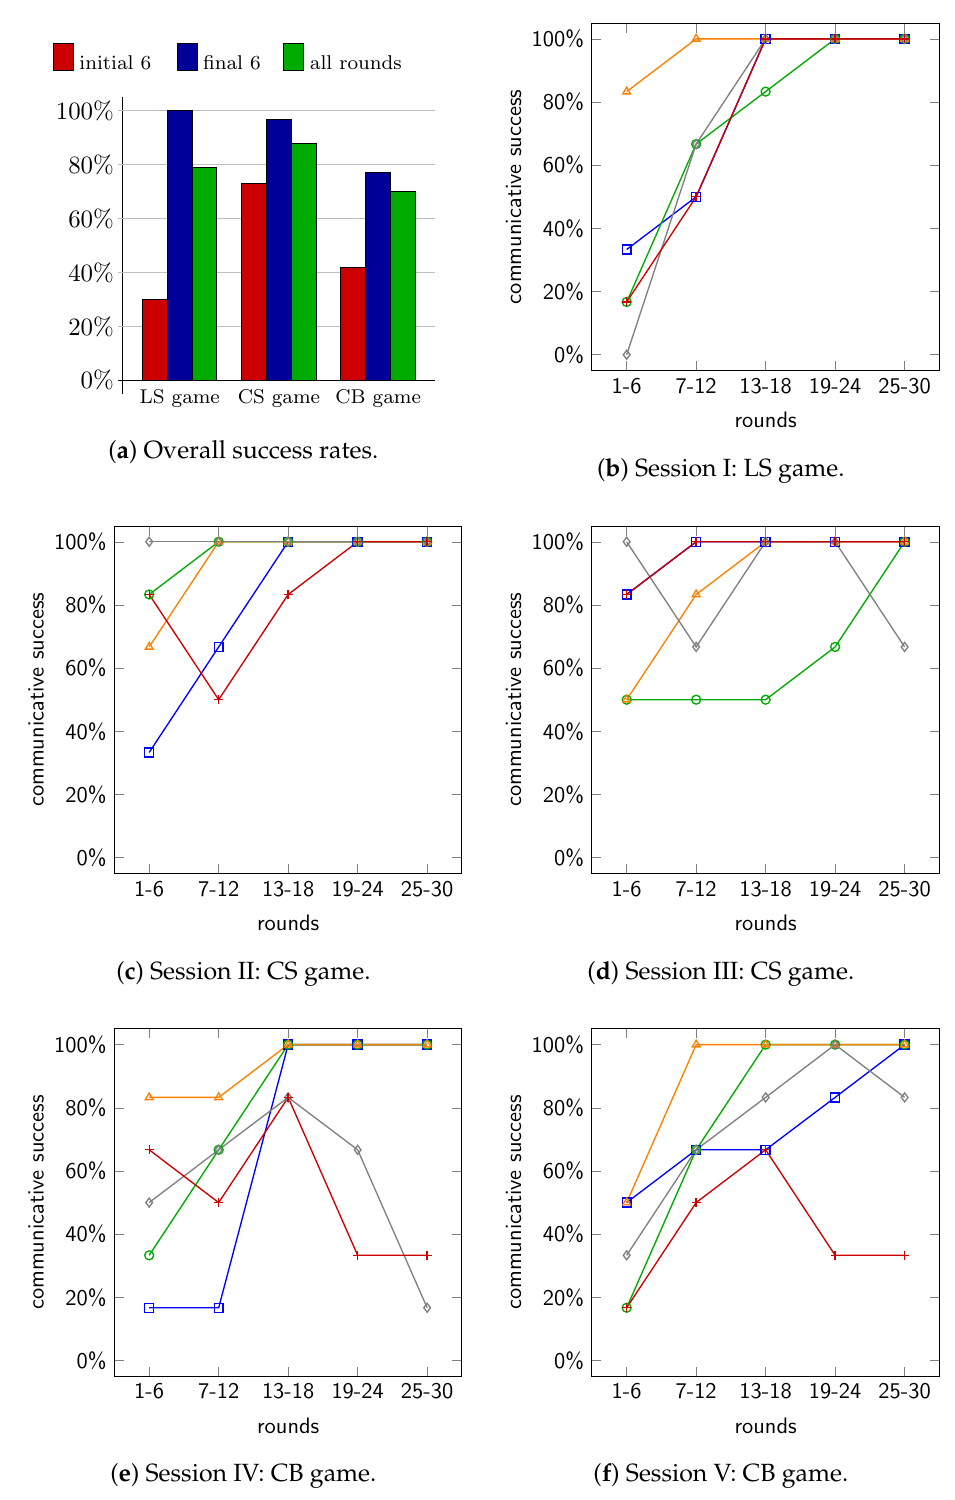
Figure 4. Communicative success (CoS) rates of the experiments. ( a ) shows the CoS rates over initial 6, final 6 and all rounds, averaged over all participants for each game type. ( b – f ) show the CoS rates over blocks of all participant pairs for Sessions I to V,